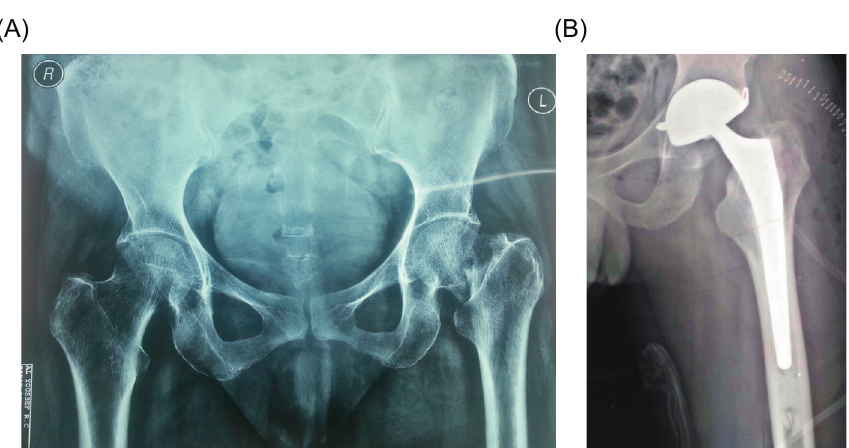
Figure 2. (A) Preoperative radiography of a 65 year old female patient with a fracture of the left femoral neck, (B) postoperative X-ray of a cemented dual mobility THA, the superior fixation screw was left due to the press fit metal cup.